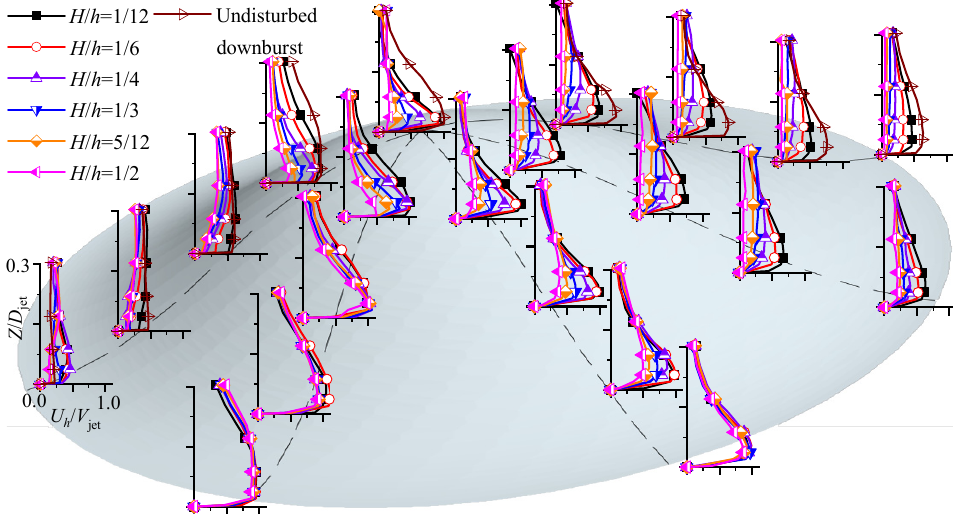
Figure 15. Profiles of horizontal wind velocity ( L = 1.0 D jet , r h = 1.0 D jet ).